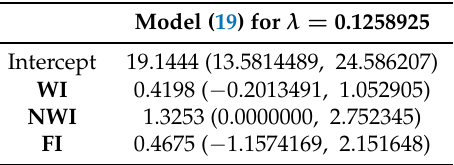
Table 13. Estimation of the Lasso model for λ = 0.1258925: Confidence interval at 10% confidence (obtained from bootstrap inside the